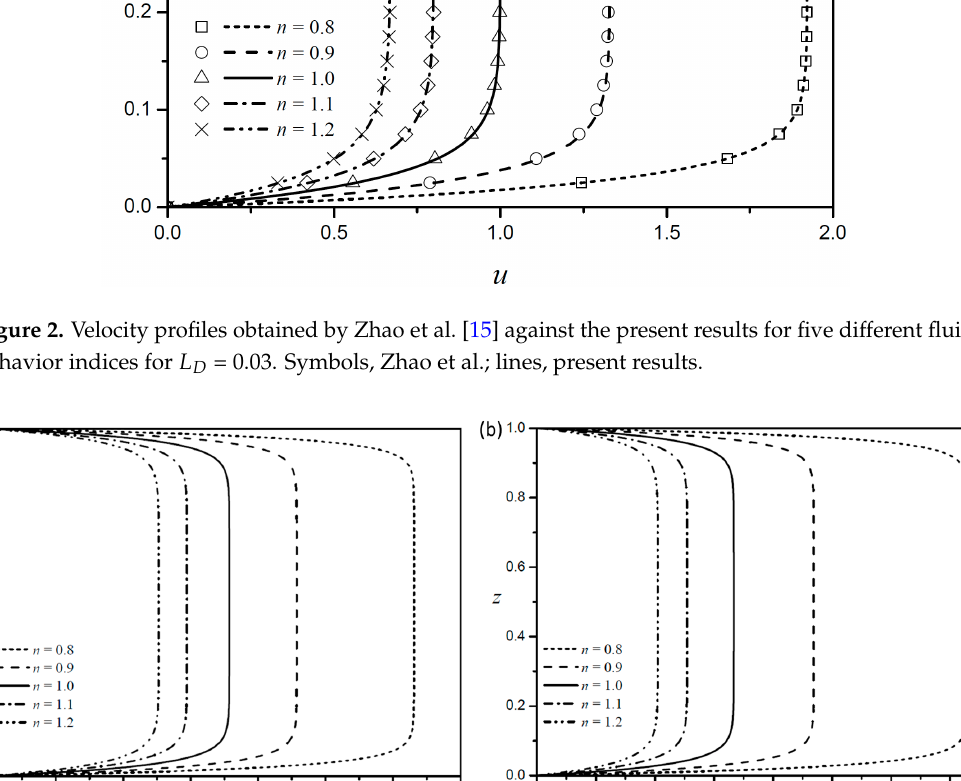
Figure 3. Velocity profiles along the centerline with A R = 1 and L D = 0.03 according to the consistency index of ( a ) a shear-thinning fluid ( n = 0.8 ) and ( b ) a shear-thickening fluid ( n = 1.2 )